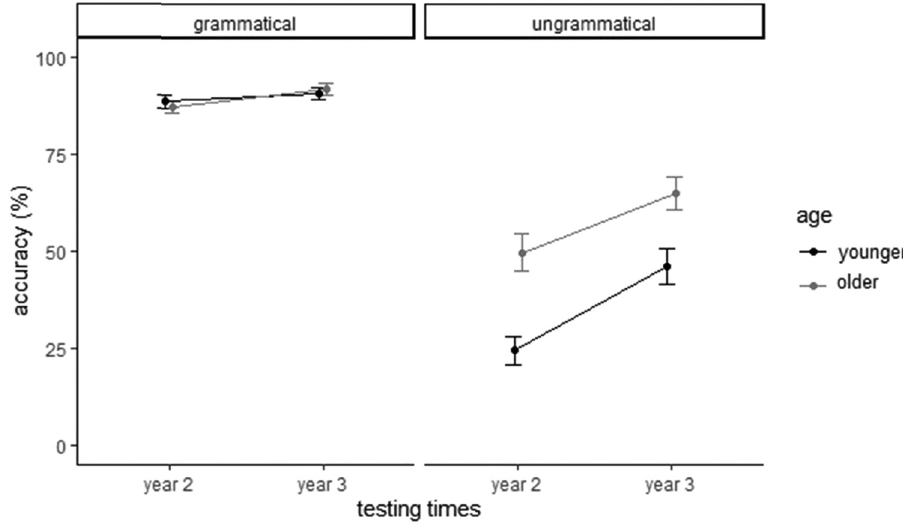
Figure 4: Correct judgments at the two testing times: grammatical versus ungrammatical